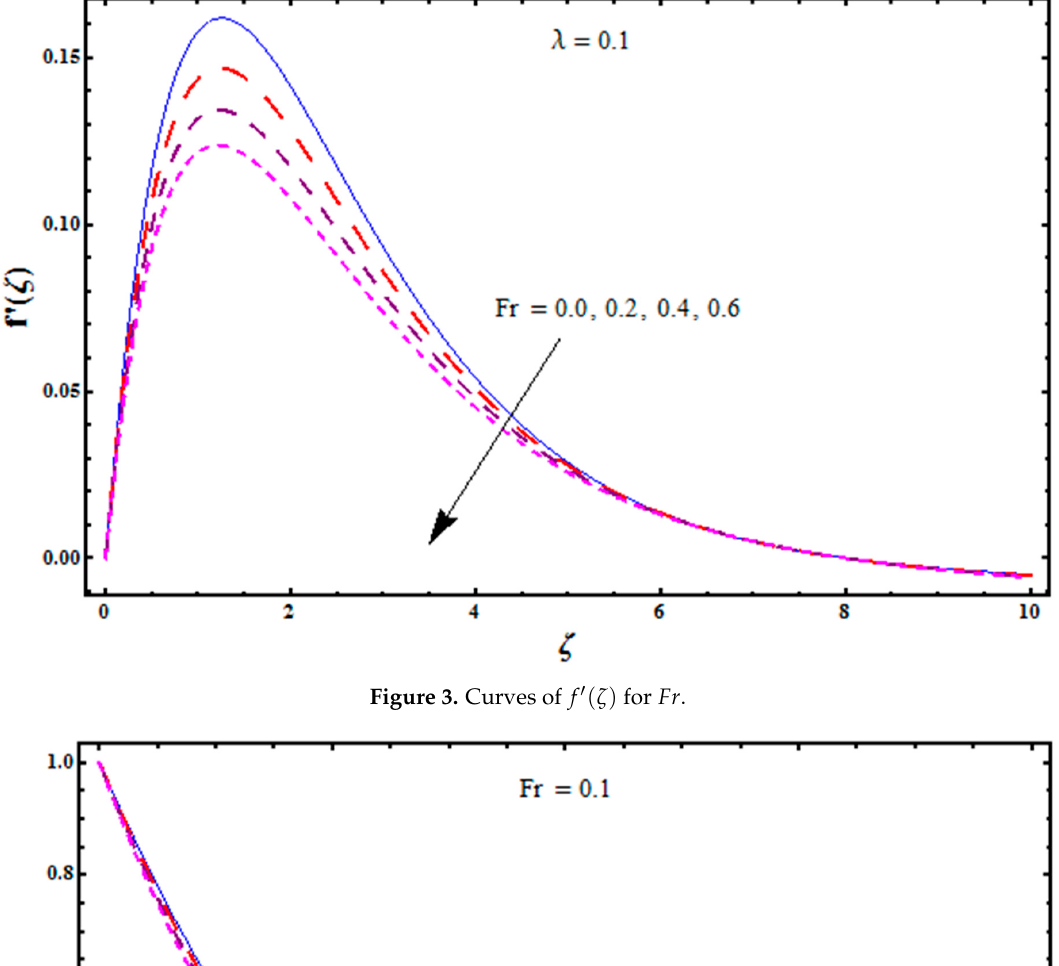
Figure 3. Curves of f (cid:48) ( ζ ) for Fr .